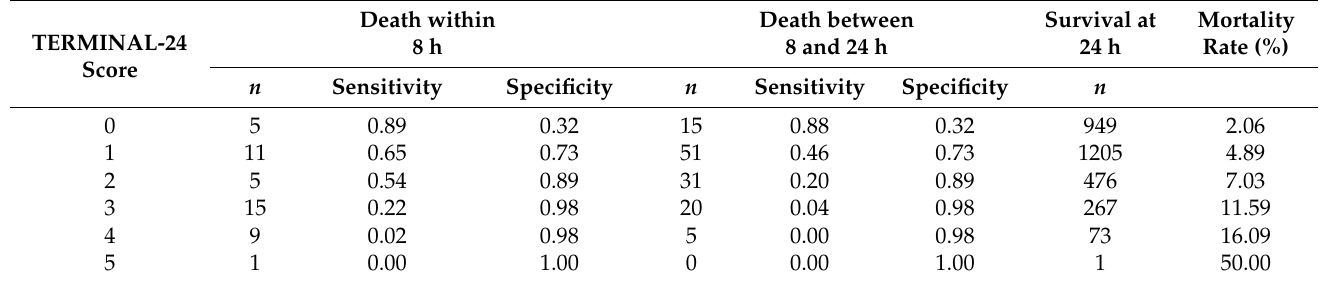
Figure 5. Risk curve of TERMINAL-24 score in ( A ) the death within 8 h group and ( B ) the death within 24 h group. The lines represent the predicted risks using TERMINAL-24 score. The circles represent the observed risks, and the size of circles represents the sample size. Table 3. TERMINAL-24 score of three groups: death within 8 h, death between 8 and 24 h, and alive at 24 h. The sensitivity and specificity were calculated for the score in the following groups: death in under 8 h and death between 8 and 24 h. The mortality rate is shown in association with the TERMINAL-24 score.